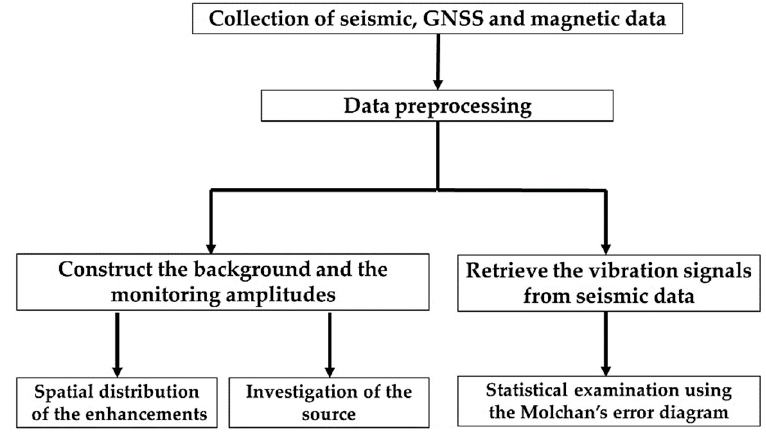
Figure 2. The flow chart of this study.